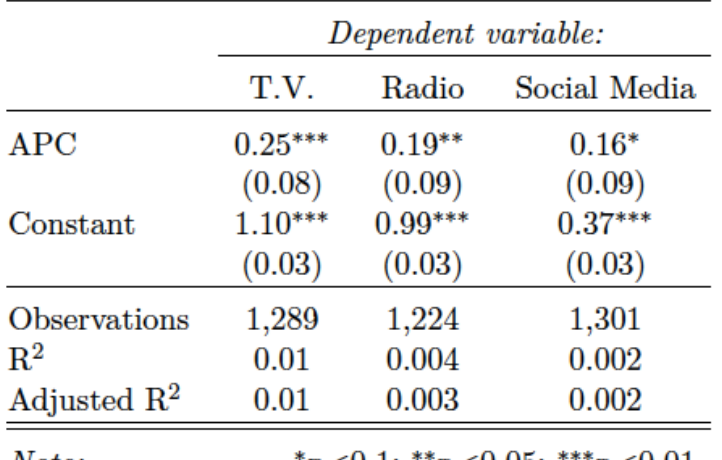
Table C9. Correlation between support for governing party and trust in different